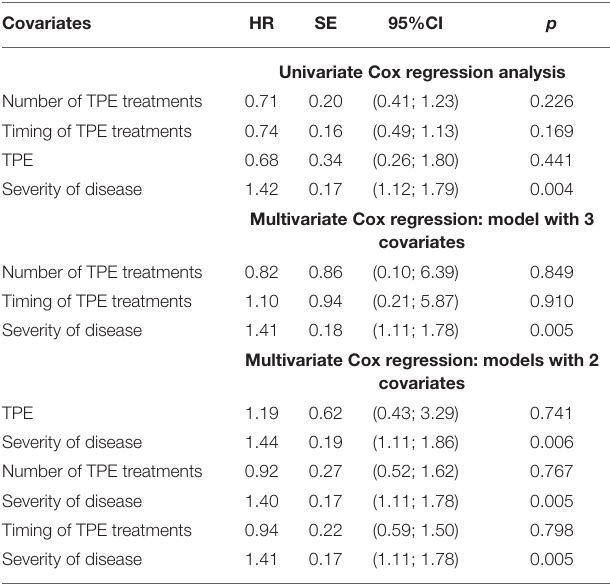
TABLE 4 | Effect of therapeutic plasma exchange (TPE) on 30-day mortality of 59 patients hospitalized for severe COVID-19 pneumonia. Covariates HR SE 95%CI p Univariate Cox regression analysis Number of TPE